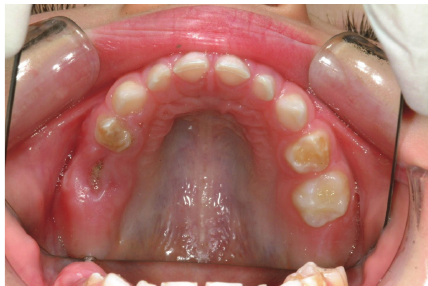
Figure 2: The lower arch.